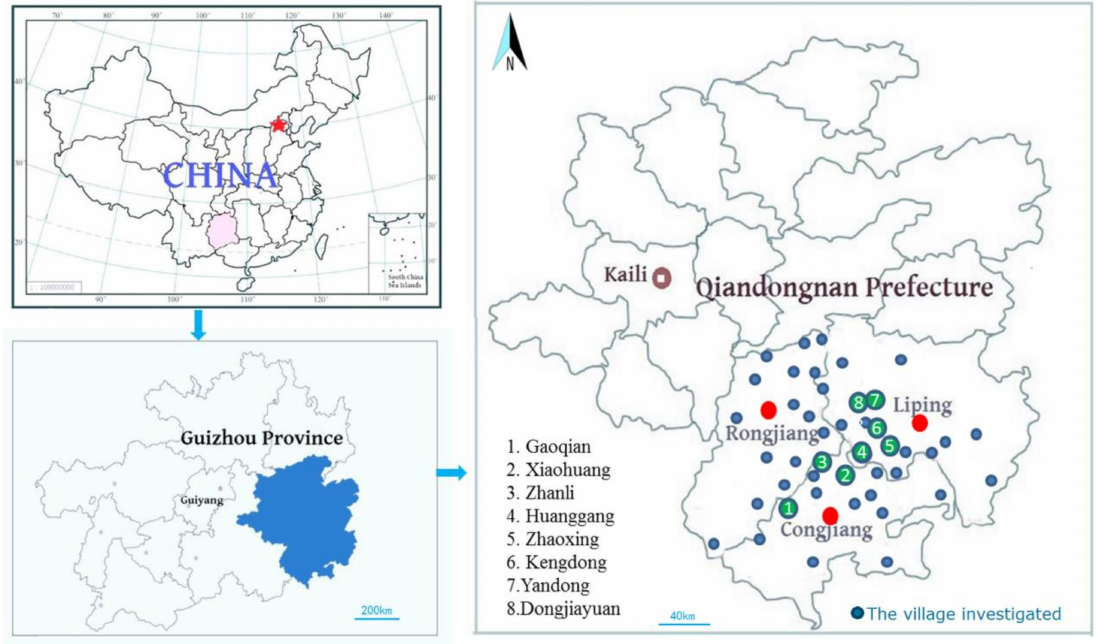
Figure 7. Sketch map of the study